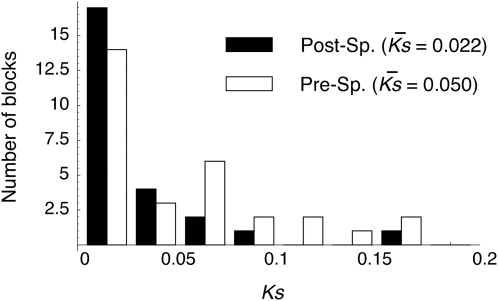
The distribution of synonymous divergence between duplicated blocks in D. melanogaster.
K̅
S is the average synonymous divergence for blocks with multiple coding genes. Post-Sp. and Pre-Sp. mean duplicates that arose after and before the speciation event of D. melanogaster and D. simulans, respectively.